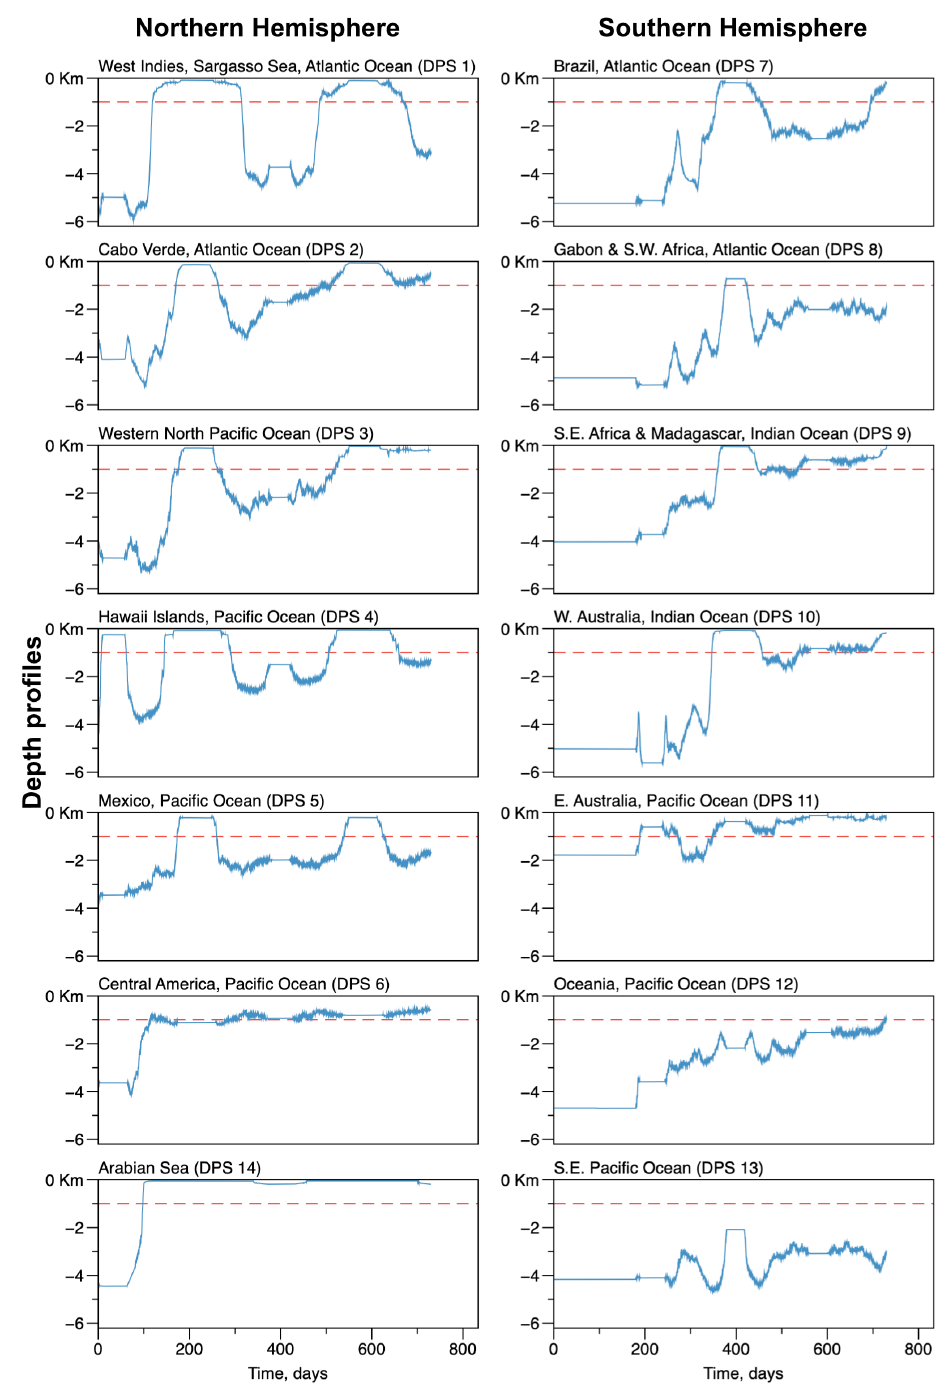
Figure 7. Average depth profile for the areas frequented by groups of whales corresponding to each of the Distinct Population Segments. In each figure, the blue line shows the depth profiles in a configuration where the depth of the ocean was constant ( − 1000.0 m) without any emerged land. The blue line shows the depth profiles in the configuration of the actual Earth topography, estimated at 1 arc-minute